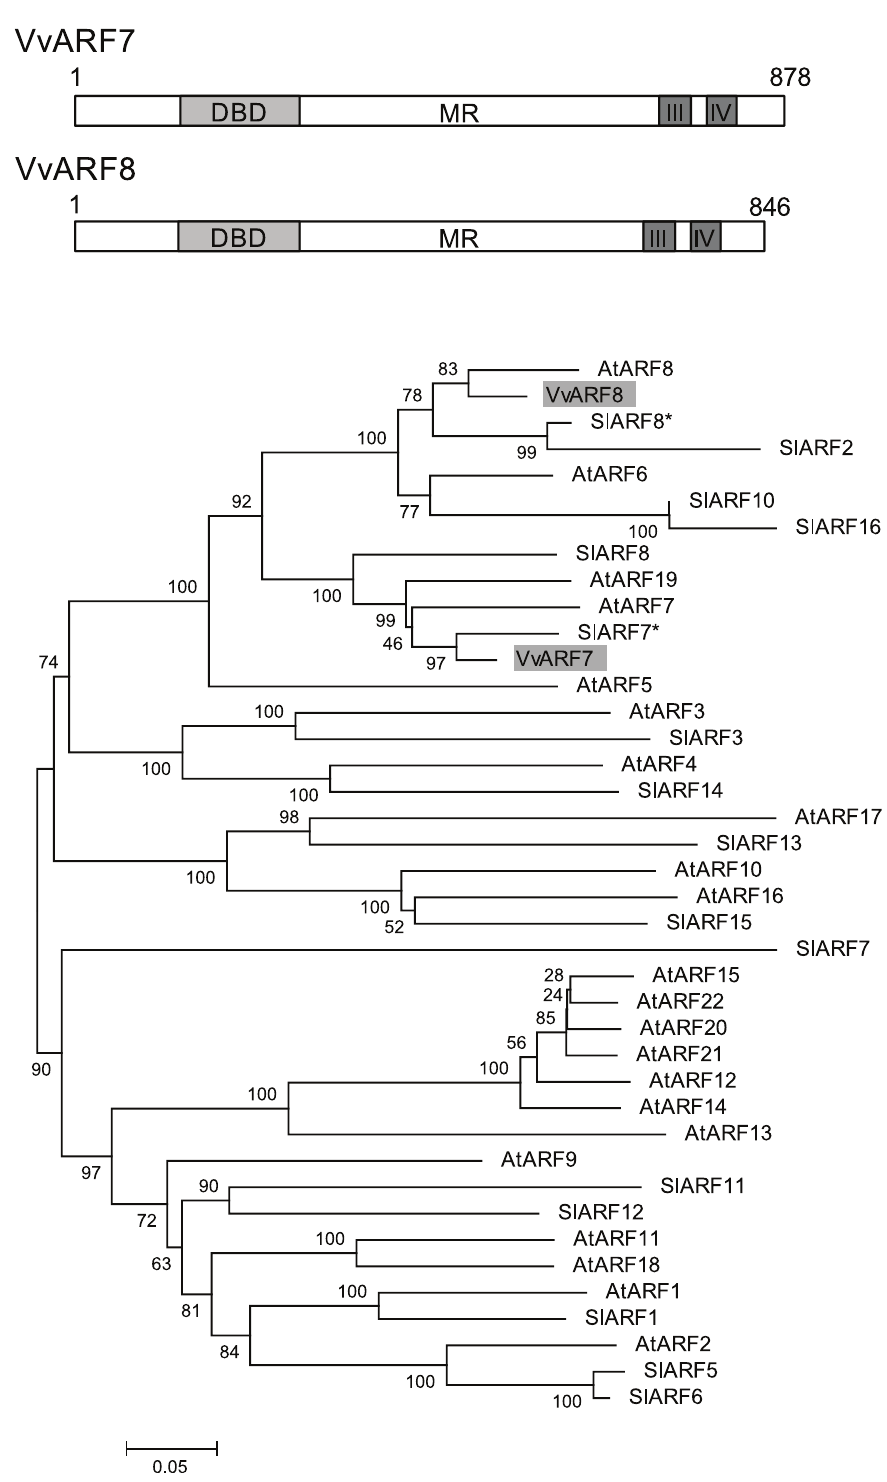
Figure 1. Protein sequence alignment and phylogenetic analysis of VvARF7 and VvARF8. ( A ) Schematic diagrams of VvARF7 and VvARF8. The length of each protein is denoted. DBD, B3 DNA-binding domain; MR, middle region; III, Aux/IAA dimerization domain III; IV, Aux/IAA dimerization domain IV. ( B ) Phylogenetic tree of Vitis ARF7 and ARF8 with Arabidopsis and tomato ARF families. Asterisks indicate previously reported SlARF7 and SlARF8 proteins, numbered SlARF9 and SlARF4 [46], respectively, based on their locations on the chromosome.